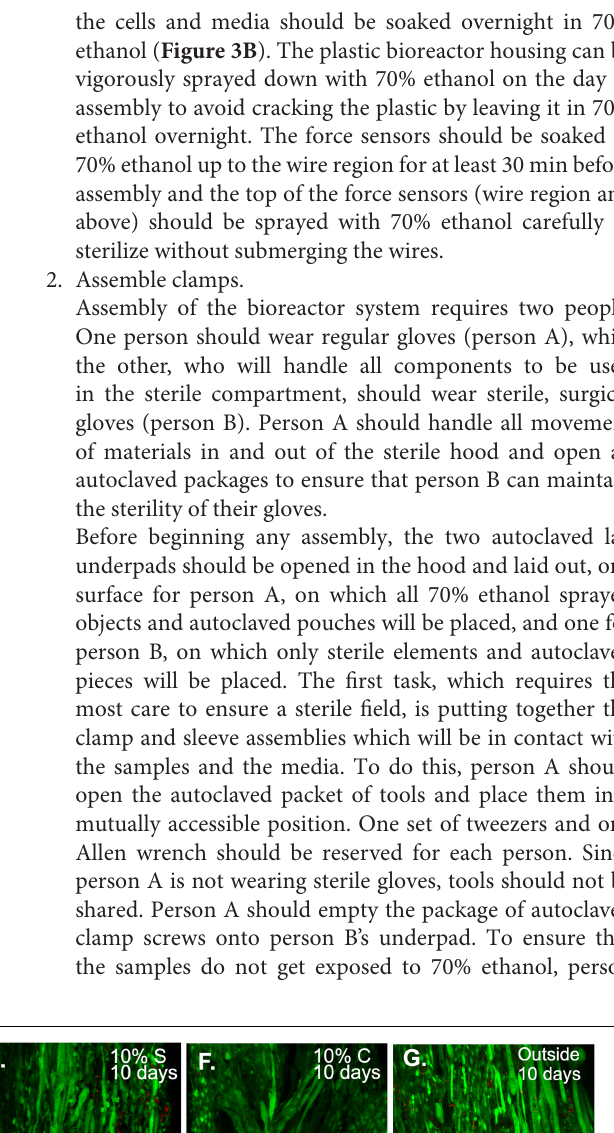
Frontiers in Cell and Developmental Biology |